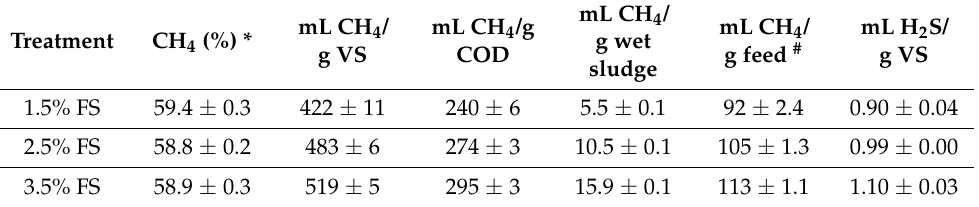
Table 3. Methane (CH 4 ) and hydrogen sulfide (H 2 S) production data from the batch digestion testing.